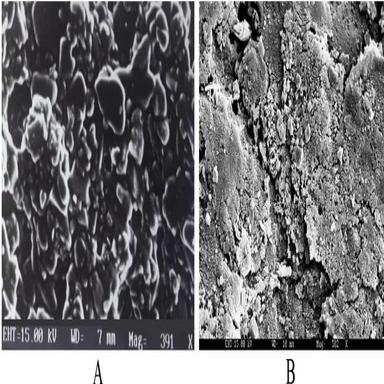
Photomicrographs of microspheres (A), and hydrogel (B).